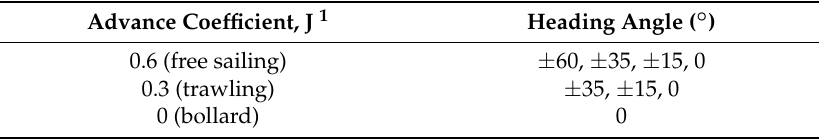
Table 2. Simulation conditions in oblique unbounded flow.